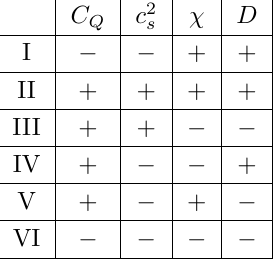
Table 1 . Signs of several physical quantities in the di(cid:11)erent regions shown in (cid:12)gure 2. Region I describes the high-temperature behavior of the system. In this